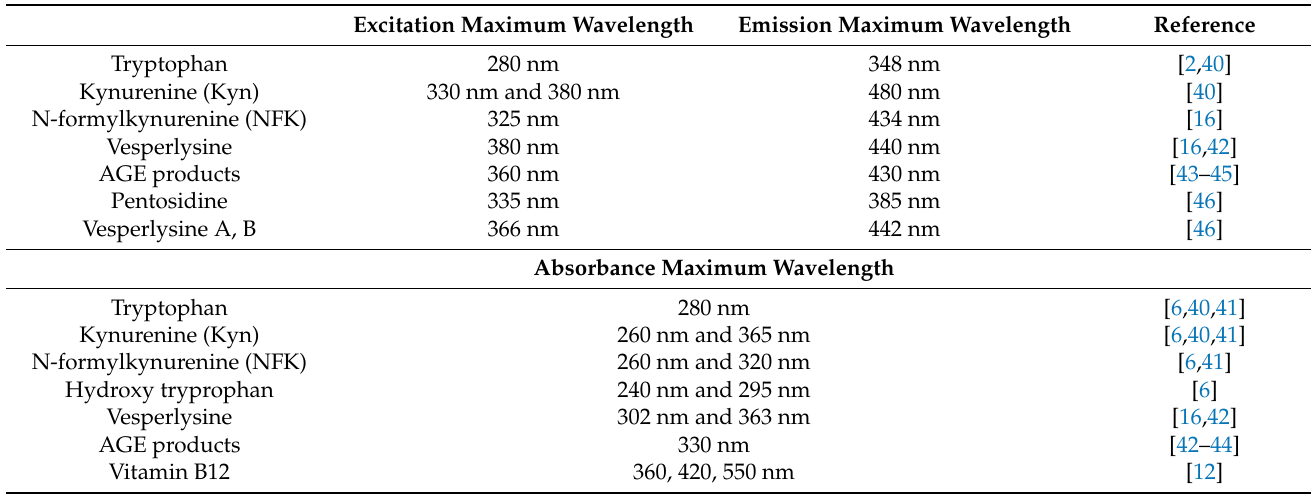
Degradation of tryptophan residues to Kyn not only modifies the absorbance proper- ties of proteins but also their fluorescence [16,41]. Formation of Kyn results in a shift of the maximum absorption wavelength from 297 nm to 330 nm and 380 nm, and maximum emission intensity wavelength from 348 nm to 480 nm (Table 2) [41]. However, detection of the tryptophan degradation products by florescence is difficult because of the low quantum yield of Kyn and the heterogeneity of the structures formed